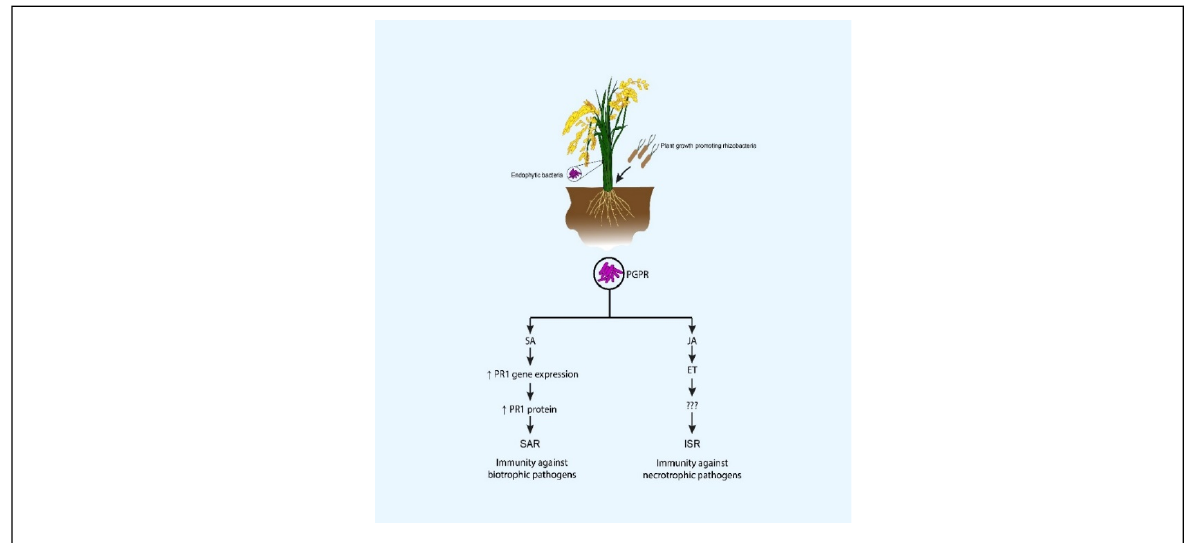
Figure 2: Phytohormonal regulation on immunity: Phytohormonal control on immunity against biotic stress achieved by Salicylic Acid and Jasmonic Acid mediated defense pathways. SA is the key player in SAR whereas ISR is mediated by JA. SAR involves PR-1 proteins which show antimicrobial action. On the other hand, JA and Ethylene become induced in induced systemic resistance. PGPB turn on SA and JA pathways and trigger rice plant to show immunity against attack by biotrophic and necrotrophic pathogens respectively. SA: Salicylic acid, JA: Jasmonic acid, ET: Ethylene. ‘?’ indicates unidentified